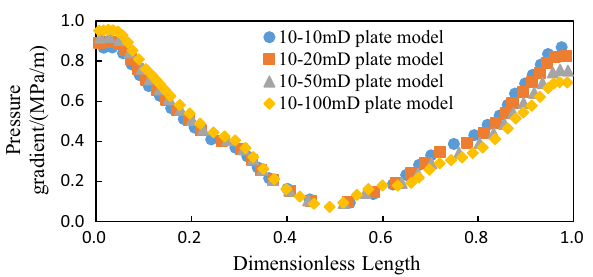
Fig. 6 Pressure gradient distribution map of connection line of injection and production points